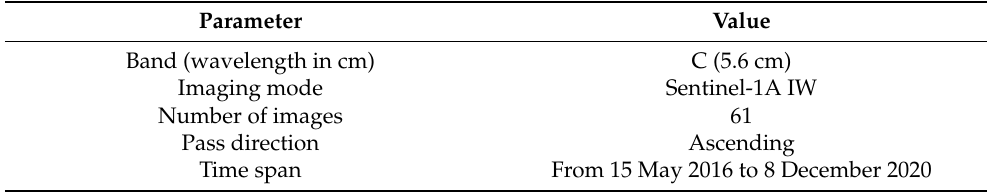
Table 1. Basic parameters of SAR images.